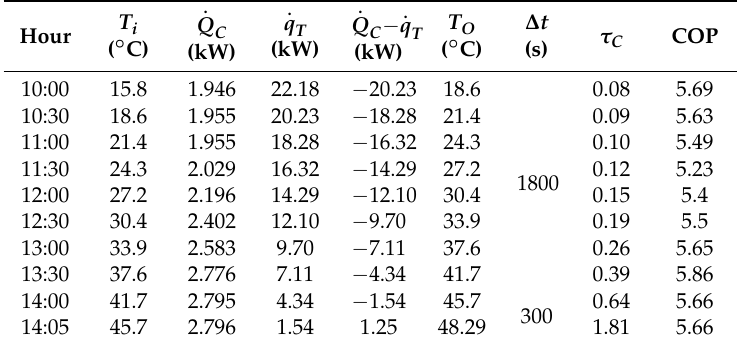
Table 2. Computation of the thermal capacity of the heat pump for the experimental data set of Cutic et al.